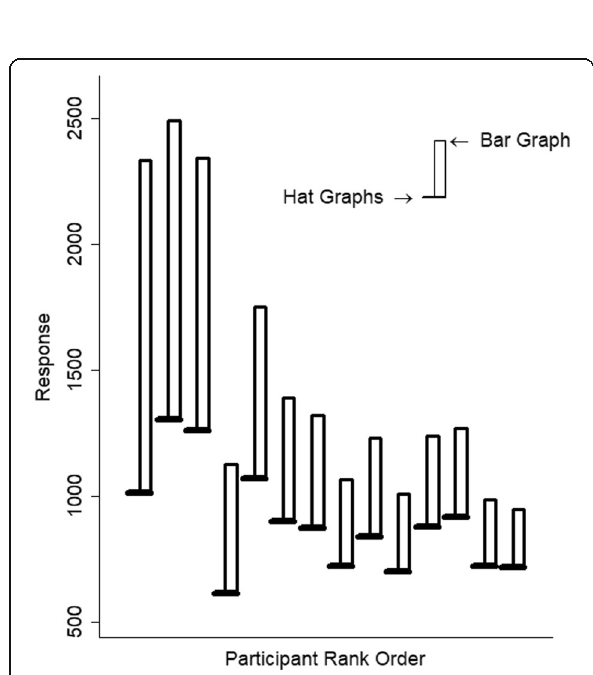
Fig. 8 Reaction time (RT) is plotted as a function of graph type and participant for experiment 2. Estimates are based on the random intercepts and slopes from the linear mixed model. The brim of the hat corresponds to the RTs for the hat graph condition, and the top of the crown of the hat corresponds to RTs for the bar graph condition. The size of the crown indicates the difference in RTs between the two conditions